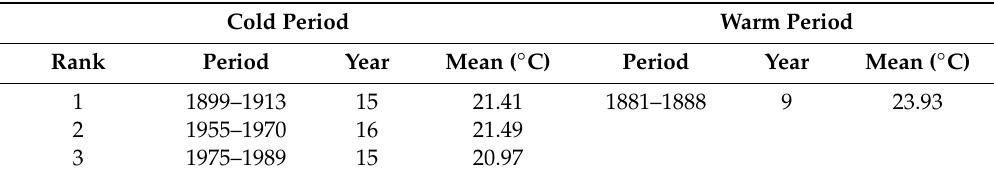
Table 4. Cold and warm periods based on the 11-year moving average June–July mean maximum temperature in the CBM region during AD 1772–2004.